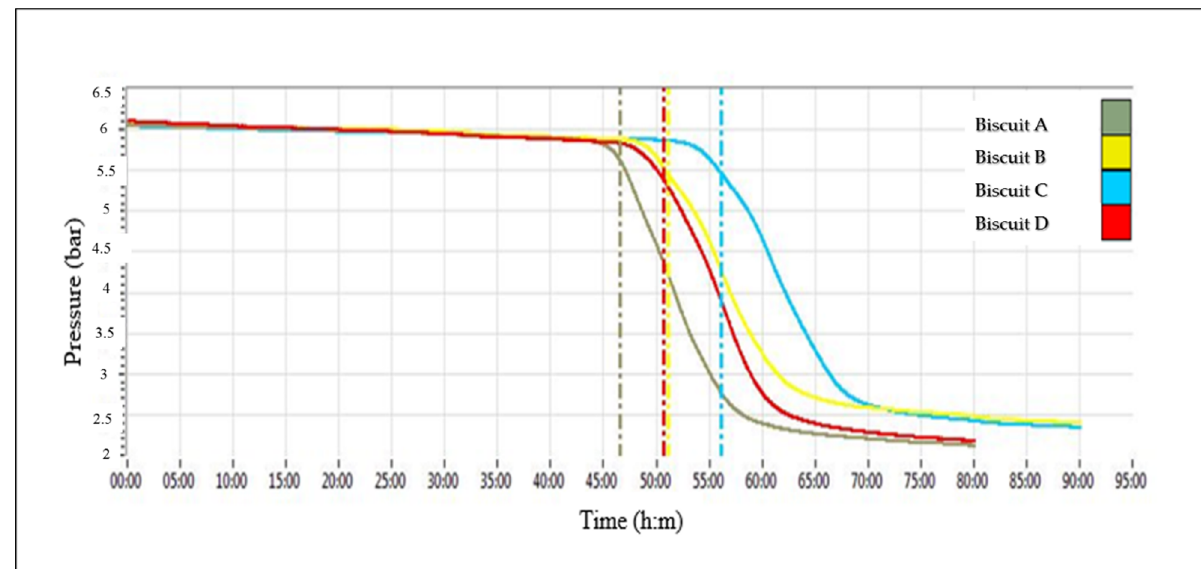
Figure 3. Oxidation curves and IP (induction period) values of biscuit samples.